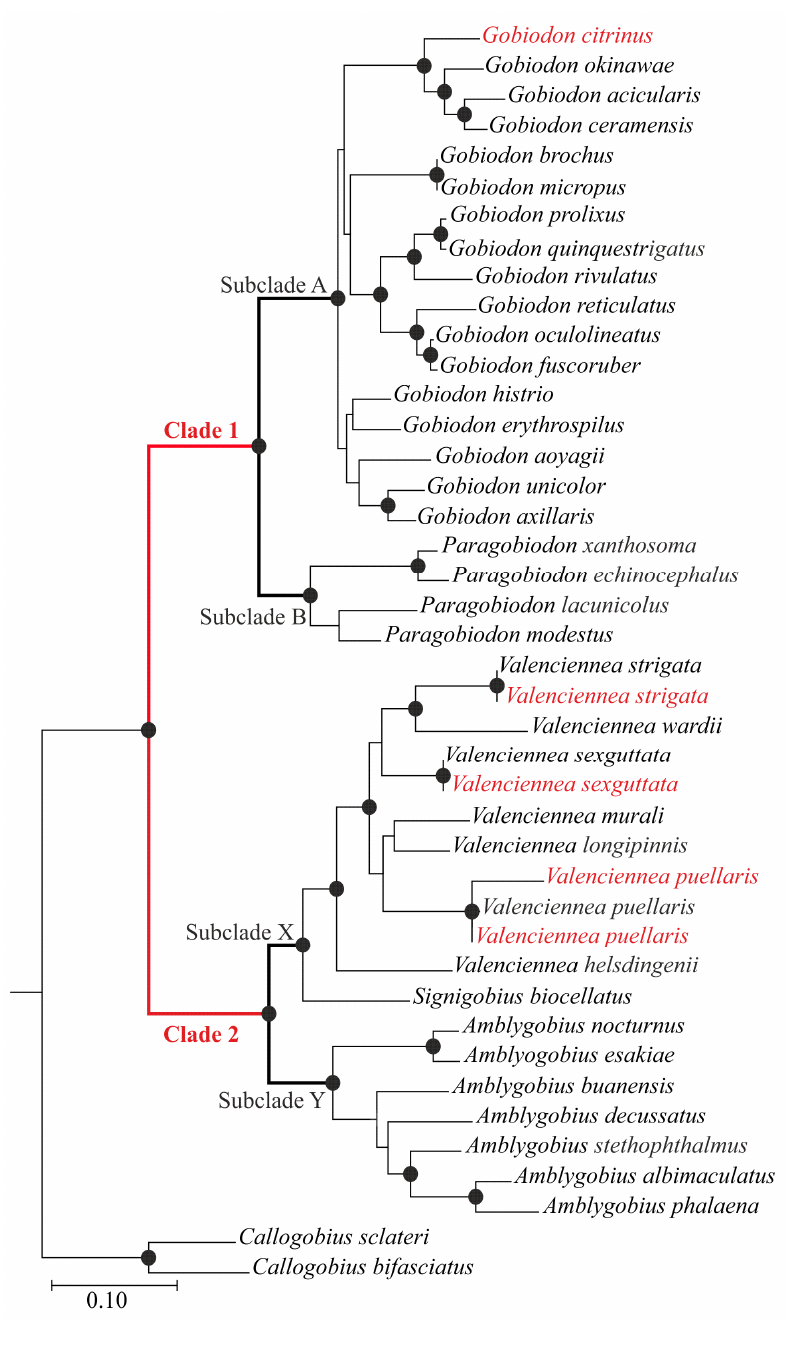
F IGURE 2. Phylogenetic relationships (ML phylogram) based on the main dataset comprising 1419 bp of two mitochondrial and nuclear (COI and Rhodopsin) markers. Filled bullets on nodes denote support for both ML (BP P≥70%) and BI (PP P≥0.95). Absence of bullet on a node denotes no support for either ML (BP<70%) or BI (PP<0.95). Four species sequenced for this study are in